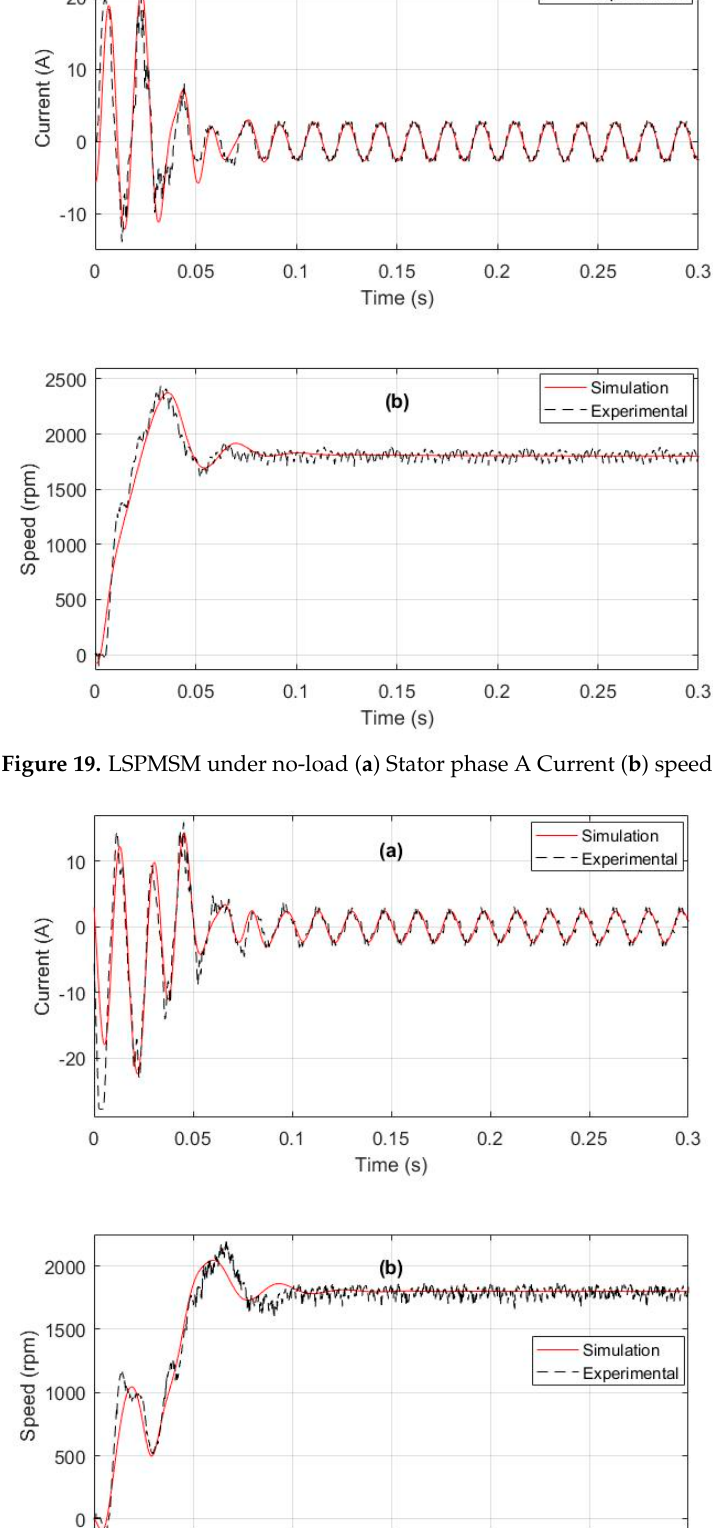
Figure 21. LSPMSM under 4 N·m load ( a ) Stator phase A Current ( b ) speed.